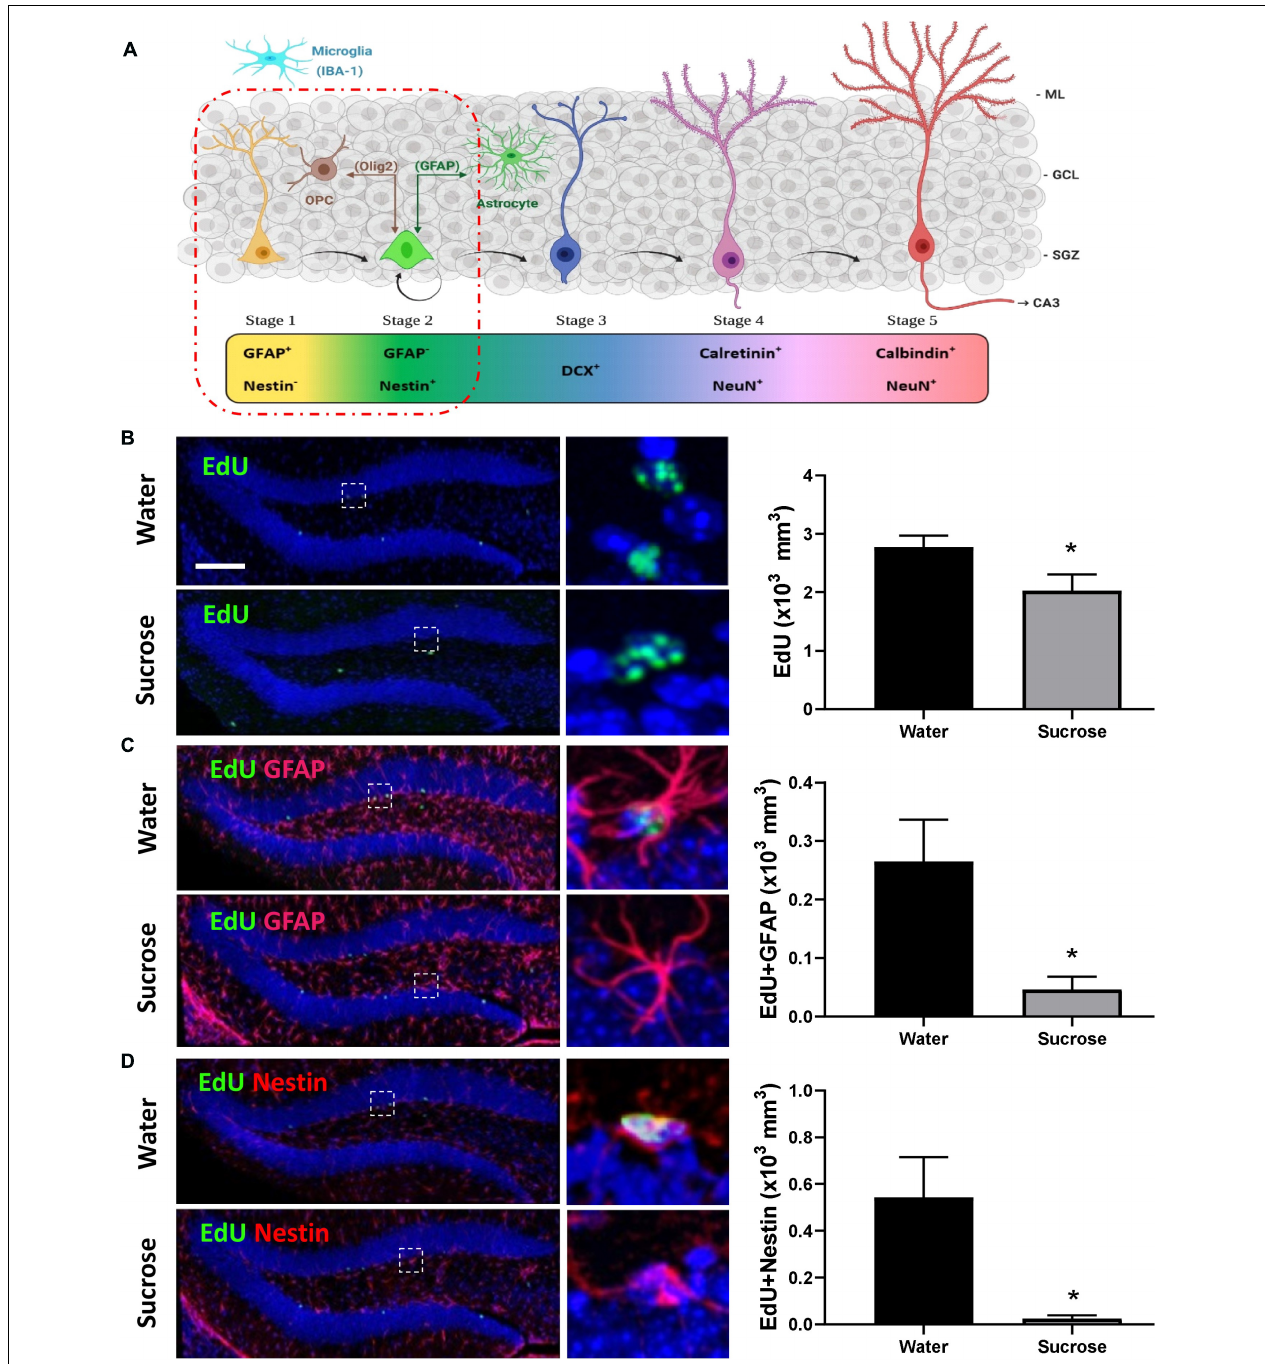
FIGURE 4 | Long-term sucrose consumption reduces the early phases of hippocampal neurogenesis. (A) Stages of neurogenesis in the dentate gyrus of the hippocampus. In stage 1 (proliferation phase; in yellow), the newly generated cells express glial fibrillary acidic protein (GFAP) and are putative progenitor/stem cells located in the subgranular zone (SGZ). The cells in stage 2 (differentiation phase; in green) will lose their GFAP and start expressing Nestin. This determines their fate in the neuronal lineage. Stage 1 progenitors not only give rise to newborn neurons, they can also turn into glial cells. Glial cells [astrocyte and oligodendrocyte progenitor cell (OPC)] can convert back into newborn neurons here in stage 2 and vice-versa. In stage 3, the immature neurons express doublecortin (DCX; in cobalt blue) and have started to migrate into the granule cell layer (GCL) of the dentate gyrus. As the neuron matures, it will send its dendrites toward the molecular layer (ML) of the dentate gyrus and extend their axonal projections toward the hippocampal CA3 pyramidal cell layer and will start losing their DCX and start expressing postmitotic neuronal marker NeuN and calretinin (stage 4; magenta). As the neuron establishes synaptic contacts from the entorhinal cortex and it sends output to the CA3 and hilus regions of the hippocampus the neuron is classified as in stage 5 (in cherry red). Stage 5 neurons start expressing calbindin and continue